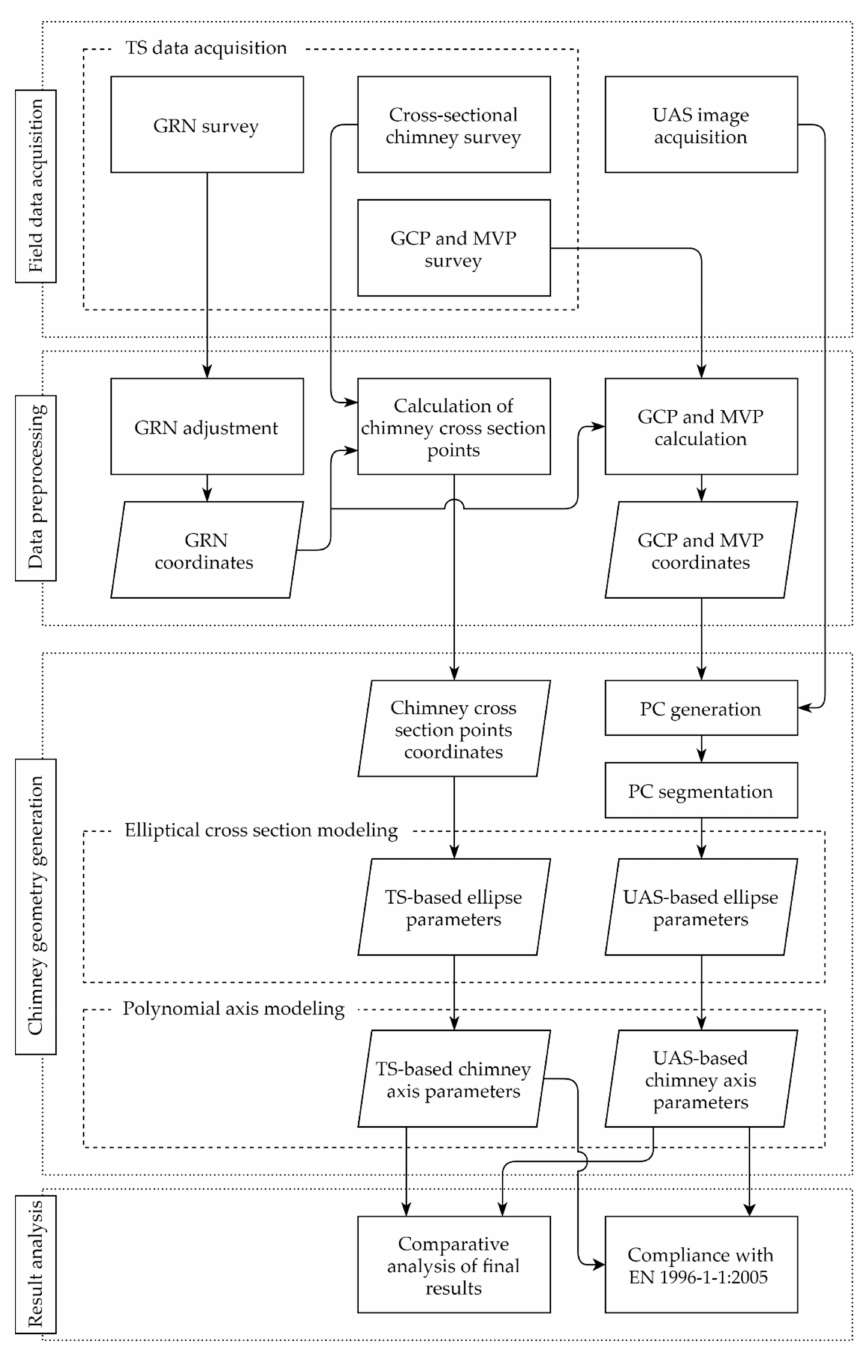
Figure 3. General research workflow; GRN—Geodetic Reference Network; GCP—Ground Control Point; MVP—Model Validation Point; UAS—Unmanned Aerial System; PC—Point Cloud; TS—Total Station. 2. Data